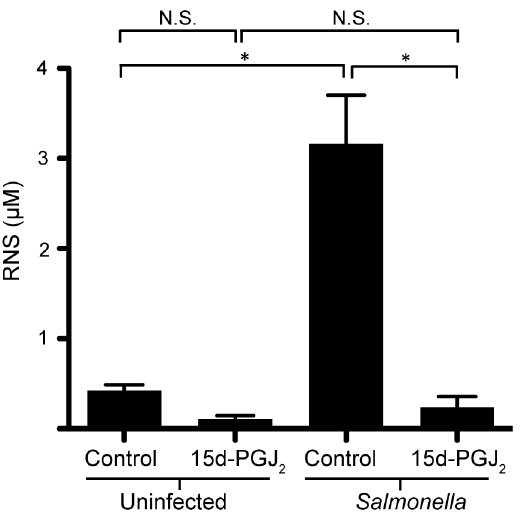
Figure 5. 15d-PGJ 2 reduces the production of reactive nitrogen species. The Griess reaction was used to determine the amount of reactive nitrogen species produced by RAW264.7 macrophages treated with 2 m M 15d-PGJ 2 and infected with Salmonella . Averages of 8 measurements are shown with standard errors of means. (*p , 0.05).